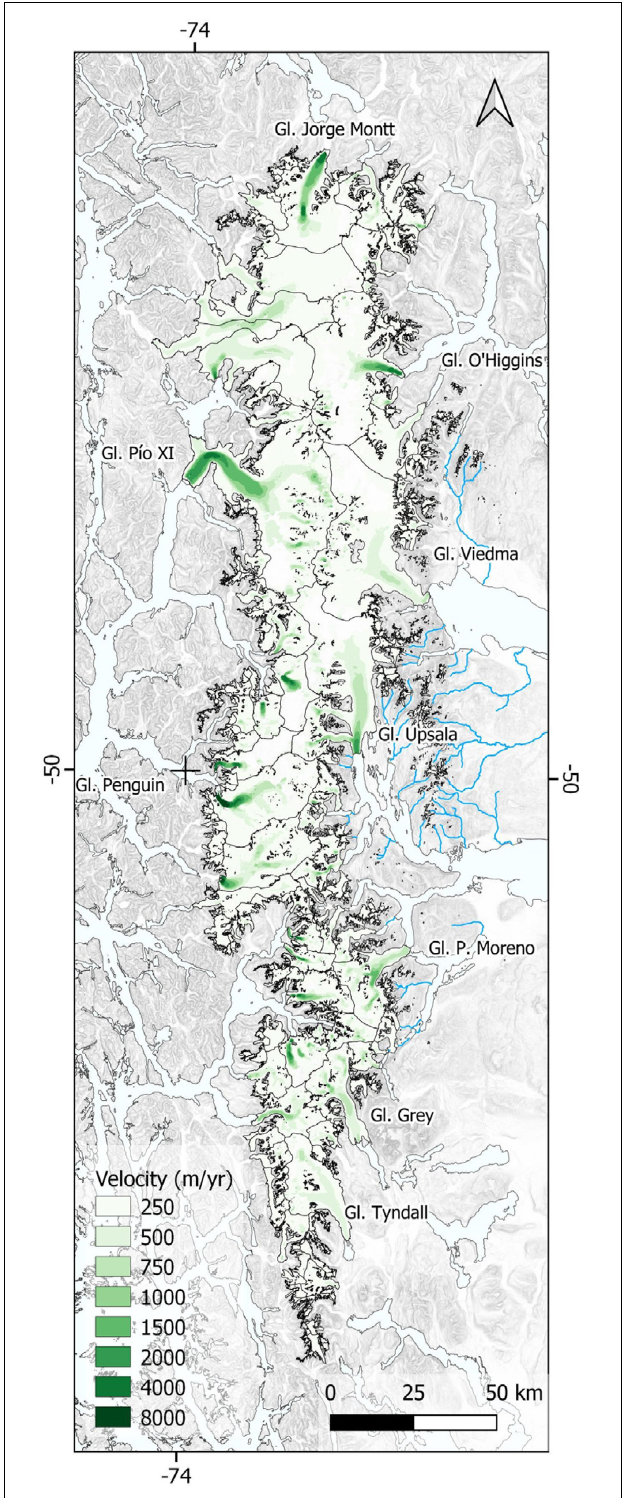
FIGURE 11 | Mean annual surface ice velocity of SPI glaciers between 2000 and 2012, derived from synthetic aperture radar (SAR; Mouginot and Rignot, 2015). High velocities can be observed along the central flowline of some of the largest outlet